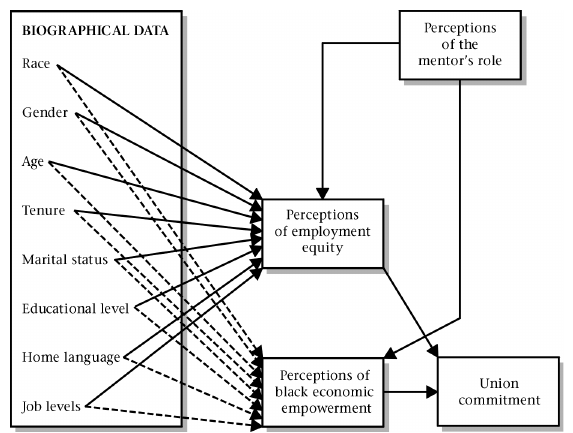
Figure 1: Predictive model of Union Commitment [Adapted from Guest (1995); Innes (2002); Iverson (1996); Lau and Woodman (1995); Mowday et al. (1982); Müller and Roodt (1998); Republic of South Africa (55 of 1998) and Storm and Roodt